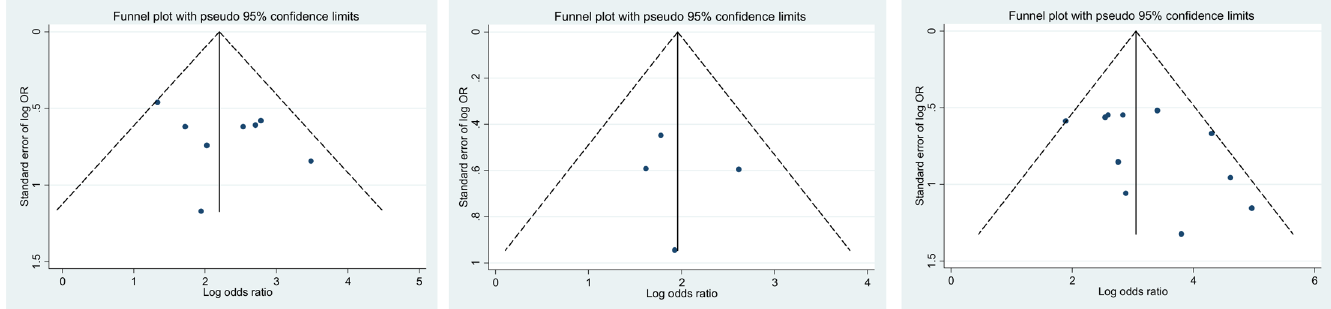
Fig 6. Funnel plots demonstrating the accuracyof the APRI (A), FIB-4 (B) and Fibroscan(C) versus the inverseof the square root of the effective sample size (ESS) for the prediction of F2–4 fibrosis. We derivedthe funnel plot and Egger test to the accuracyof meta-analysis inferences. Continuous lines represent the overall estimates of test accuracy. The Egger test did not detect a significantpublication bias (p > 0.05). For Fibroscan, the Egger test shows a borderlinesignificantp-value (p = 0.0535) for Fibroscandata, which is driven by an outlier, the study by Carrionet al (2006).